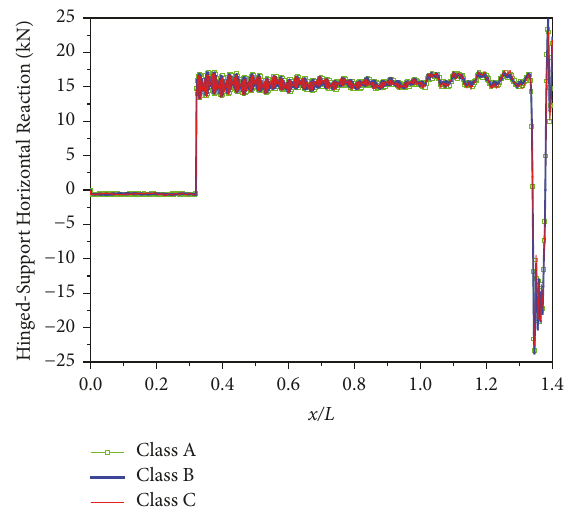
Figure 16: Longitudinal reaction at hinged support of simply supported beam with different roughness class.